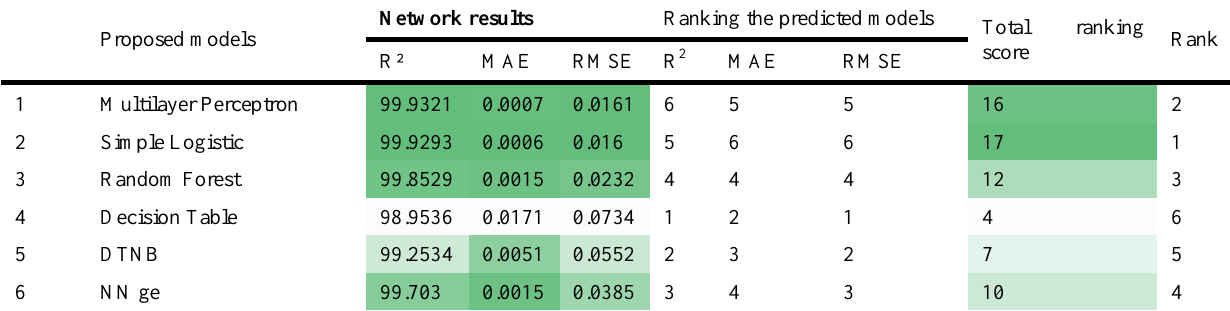
Table 2. Image classification algorithms evaluation based on the training dataset.